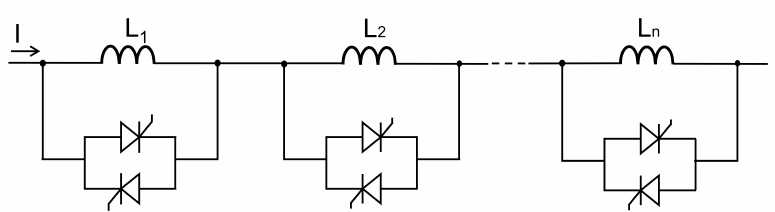
Figure 1. Thyristor switched series compensators (TSSC) basic scheme.